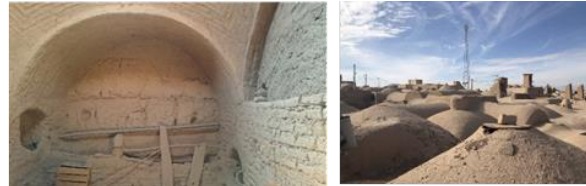
Figure 10. The material of adobe and straw-clay in these houses.